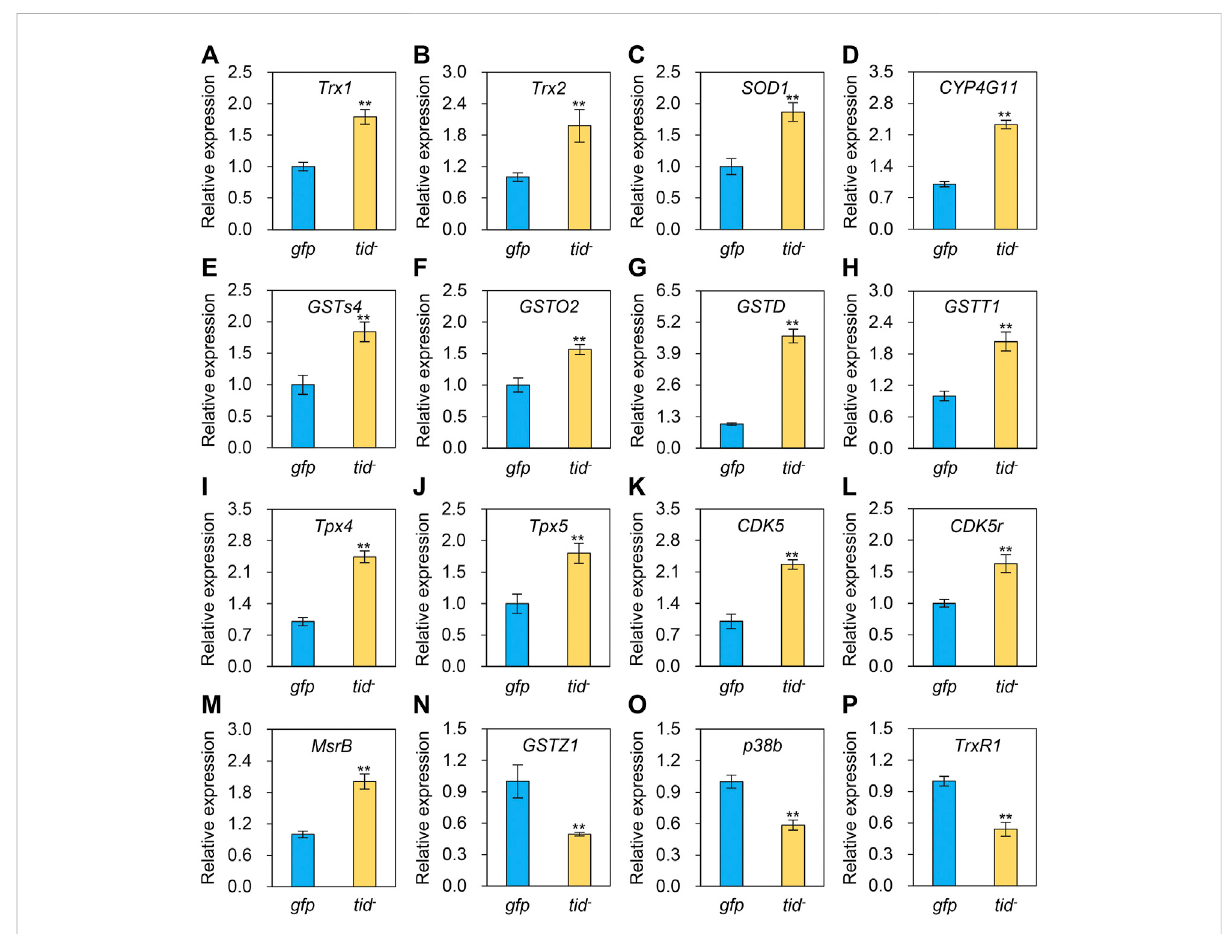
FIGURE 9 Effects of AccTid knockdown on the expression pro fi les of sixteen antioxidant genes (A – P) . tid- : knockdown of AccTid. gfp : GFP control. Signi fi cant differences between two groups are indicated by ** p < 0.01 based on Student ’ s t -test. β -actin was used as an internal